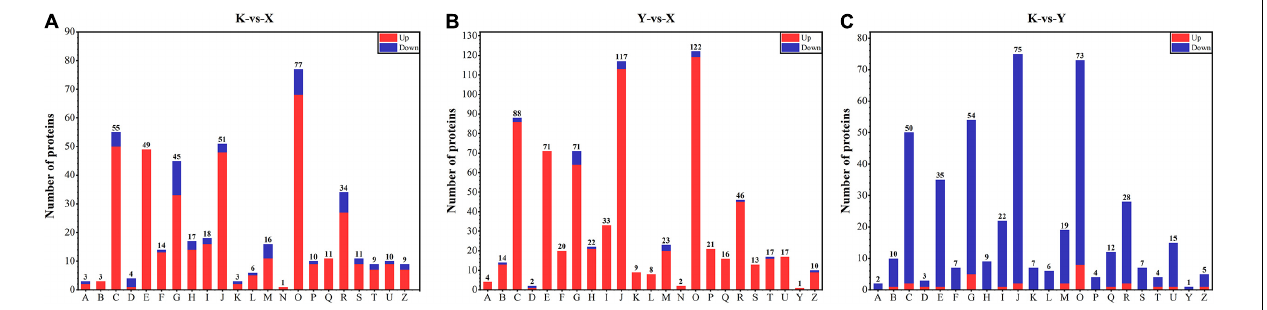
FIGURE 5 | Functional classification of DAPs by COG database. (A) Functional classification of DAPs identified in shade-drying vs. fresh. (B) Smoke-drying vs. fresh. (C) Shade-drying vs. Smoke-drying.